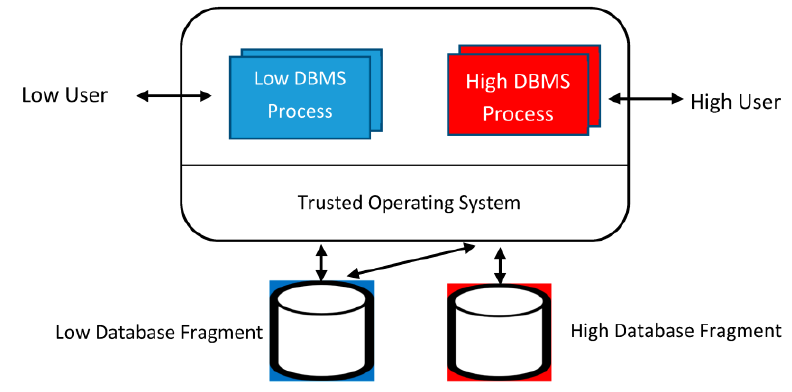
Figure 3. SeaView subset architecture.